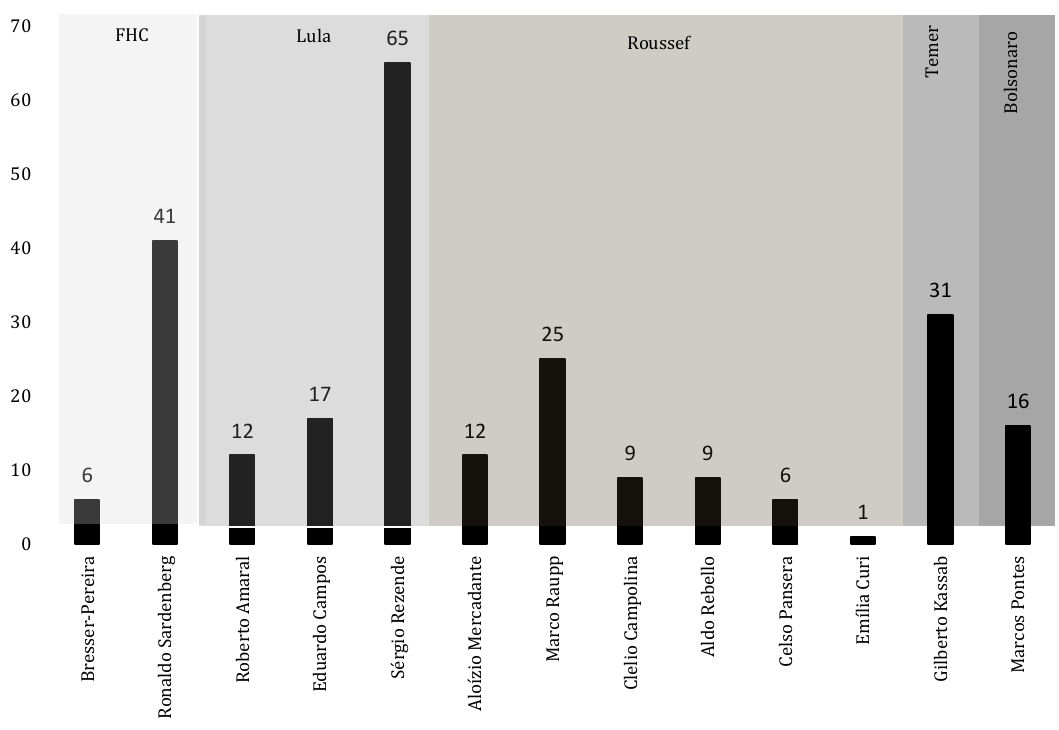
Figure 03 . Terms of office of ST&I ministers, in months